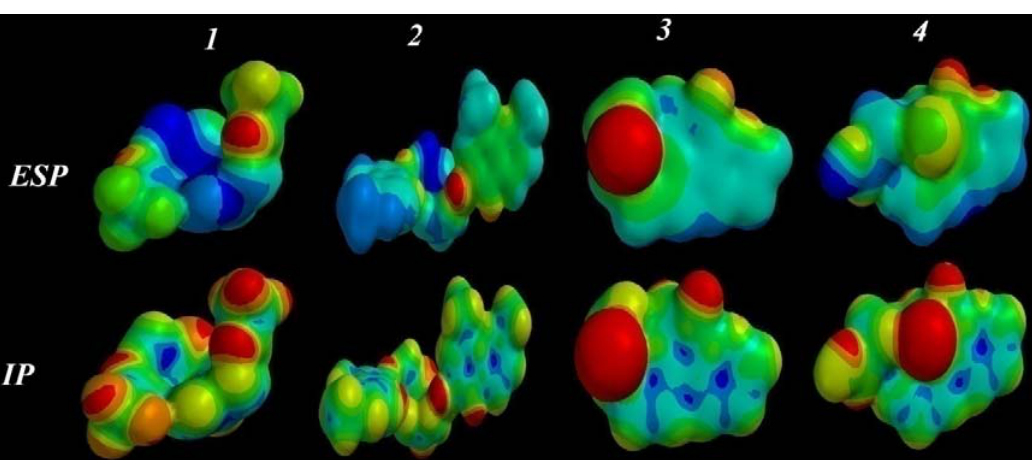
Figure 6. The ESP and IP surfaces for 1 – 4 by PM3 semi-empirical